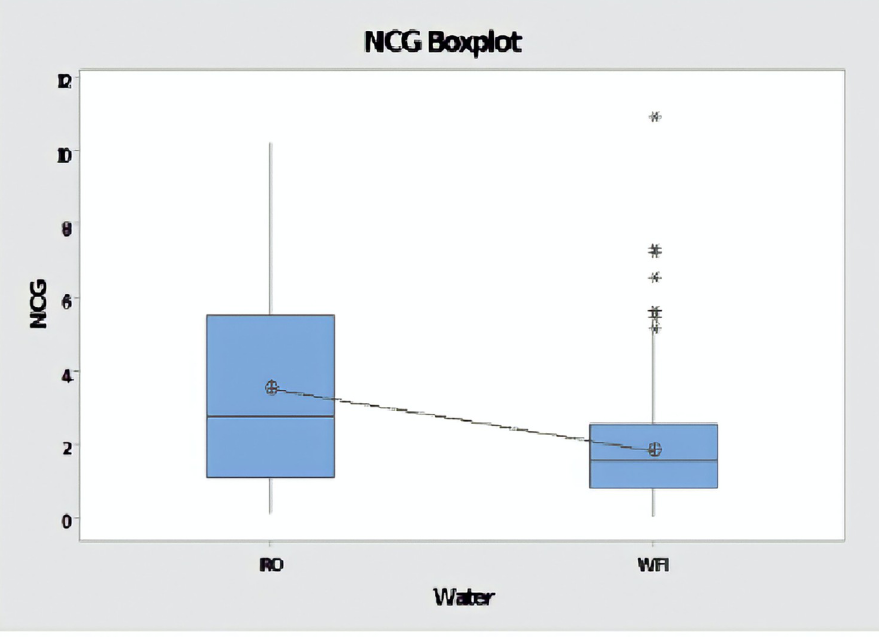
Fig 3. Box-plot of distributions of NCGs concentration comparing tests performed with reverse osmosis water (RO) and water for injection.